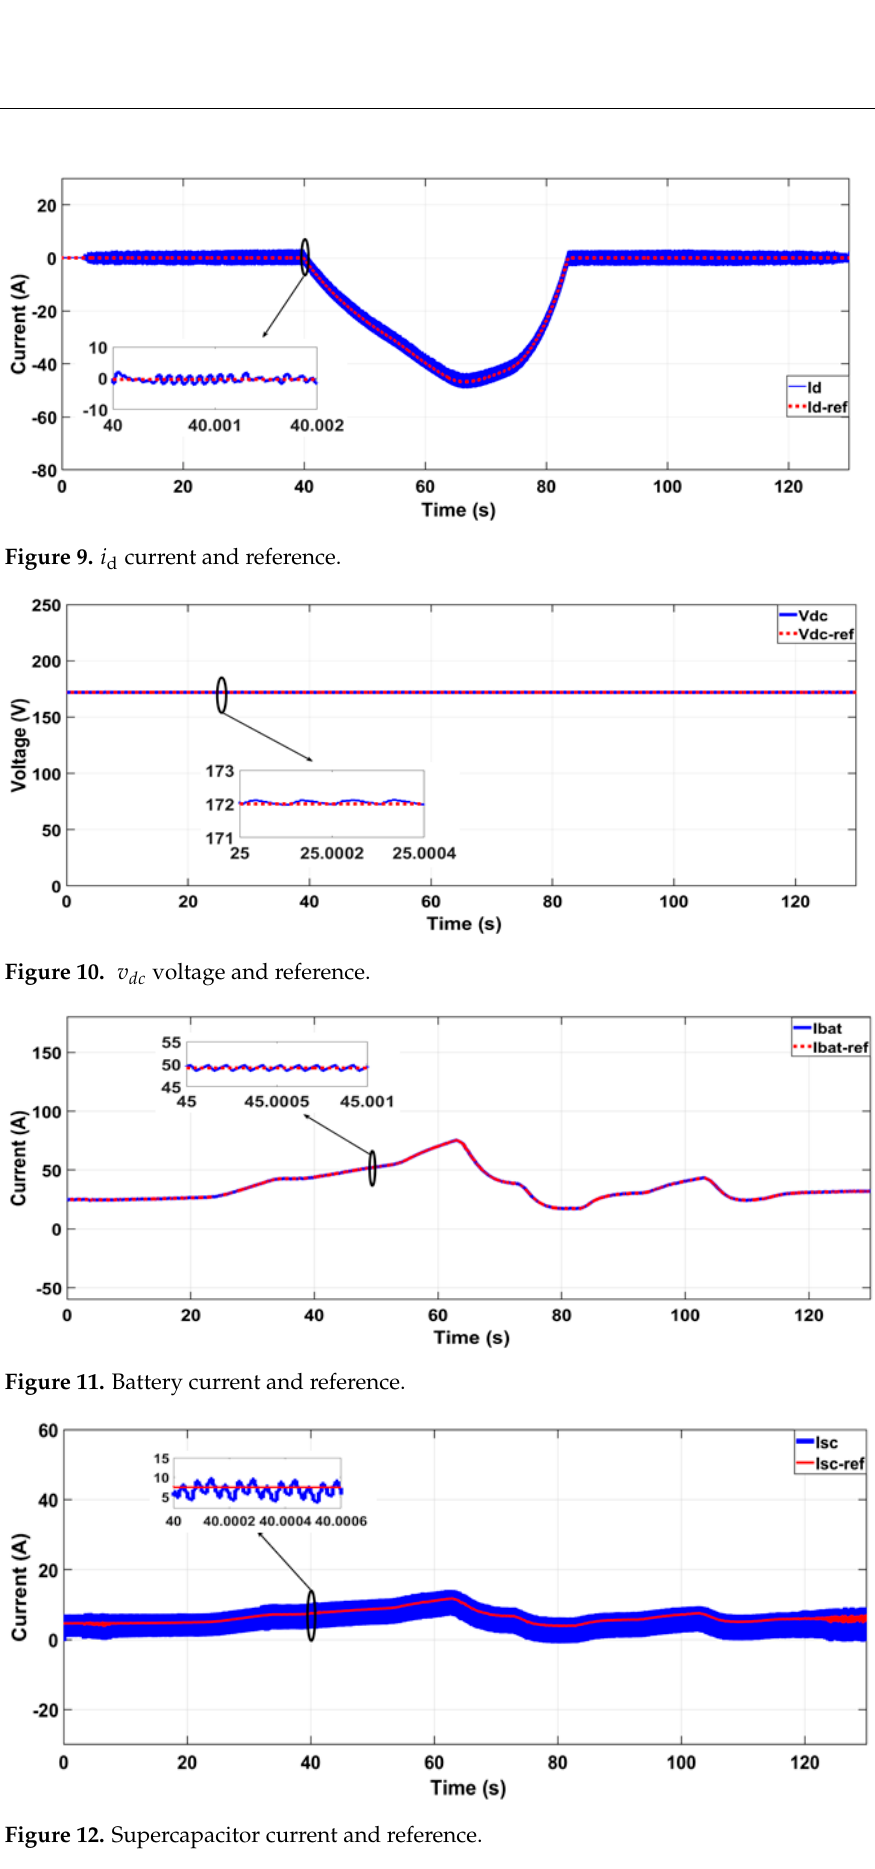
Figure 13. Battery voltage 𝒗 𝒃𝒂𝒕 . Figure 14. Supercapacitor voltage 𝒗 𝒔𝒄 . In Figures 6 and 10, the proposed HESS Bq-ZSI shows the quick responses to the mechanical load and provides a constant DC-link voltage over the power-demand profile. The battery, the supercapacitor, and the total power of the proposed HESS during EV motor traction in the high-power mode are presented in Figure 15.